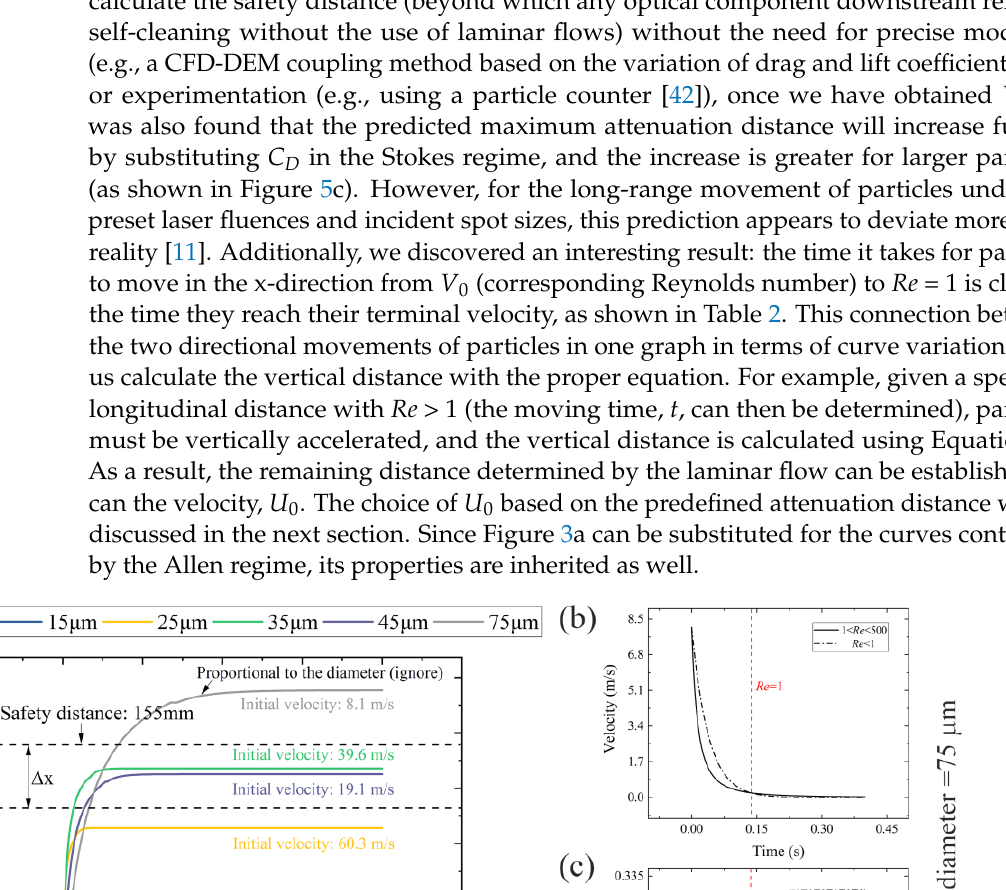
Table 1. Longitudinal velocity (Reynold number) of particles extrapolated at 13,000 ns.